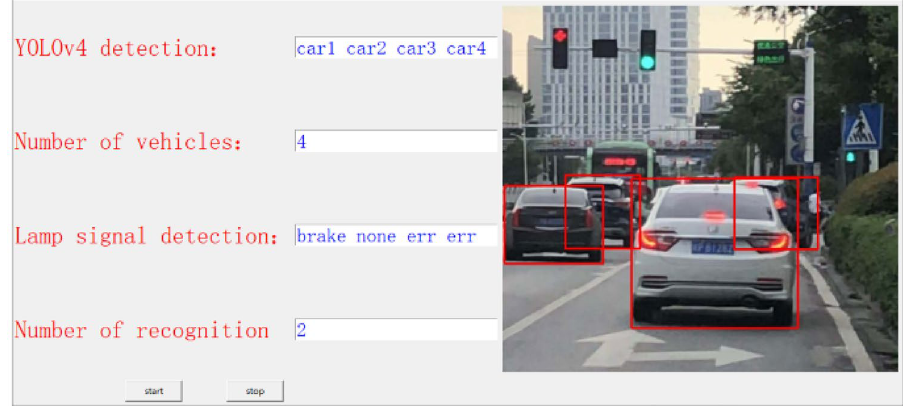
Fig. 13 Visual interface in real vehicle test